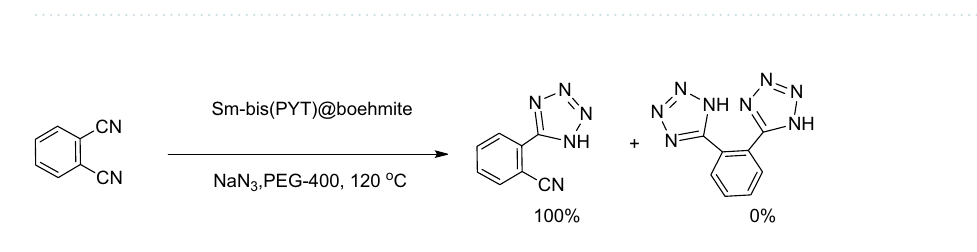
Figure 12. Homoselectivity of Sm-bis(PYT)@boehmite in the synthesis of 5-substituted 1H-tetrazoles from [3 + 2] cycloaddition of NaN 3 with dicyano substituted